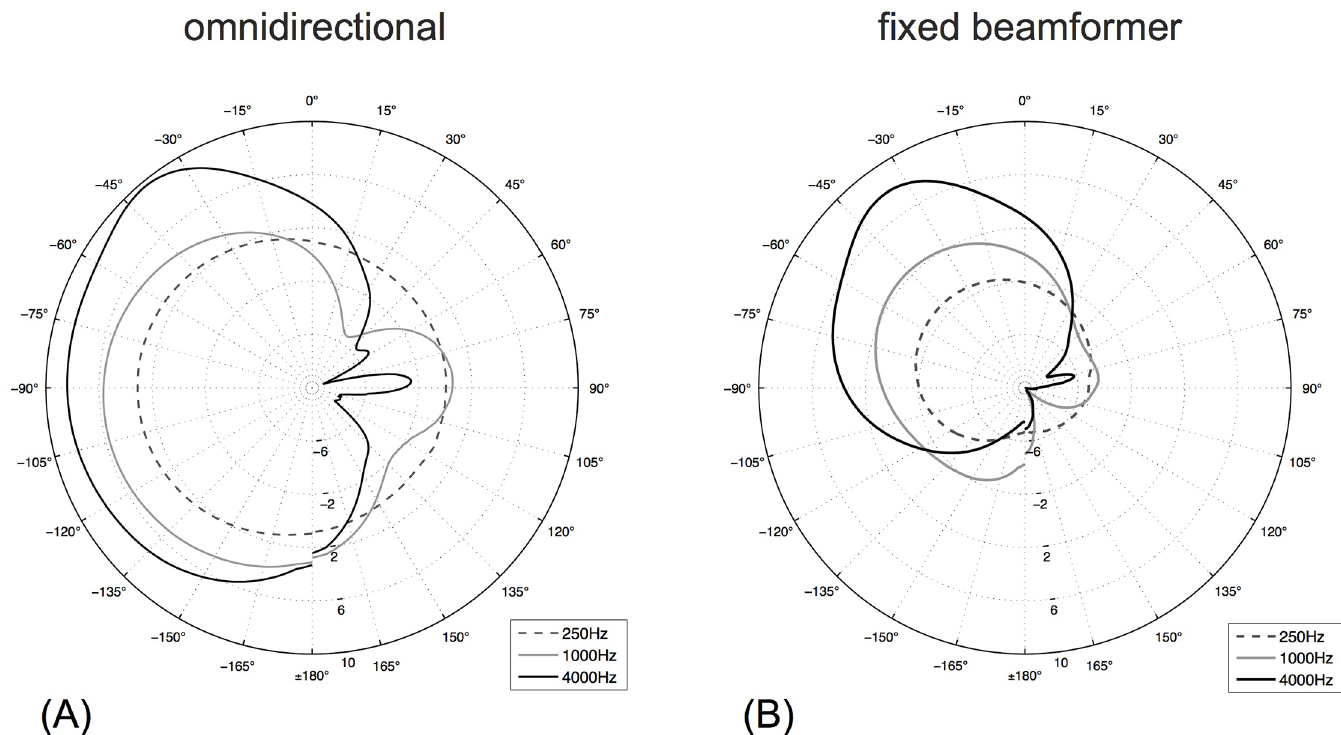
Fig 2. Microphone directivity patterns. Microphone directivity patterns of the SONNET audio processorat different frequencies for (A) the omnidirectional setting, and (B) the fixed beamformer setting, normalized to 0 dB for 0˚ azimuth at 1000 Hz. Measurements were performed in an anechoic chamberwith the audioprocessor placedon the left ear of a KEMAR